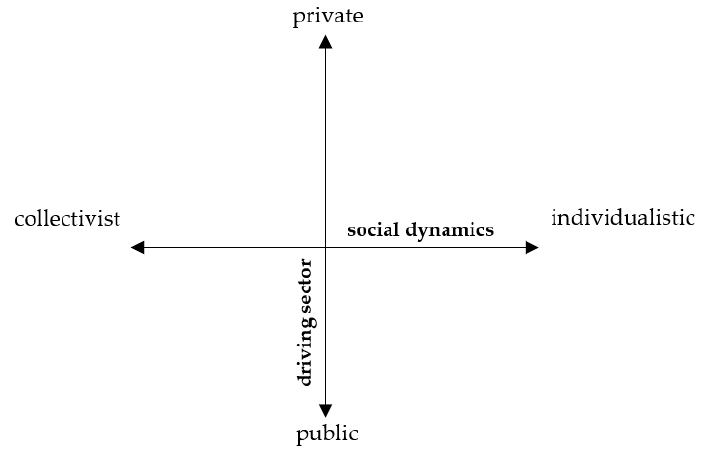
Figure 2. Dimensions of the four future scenarios.